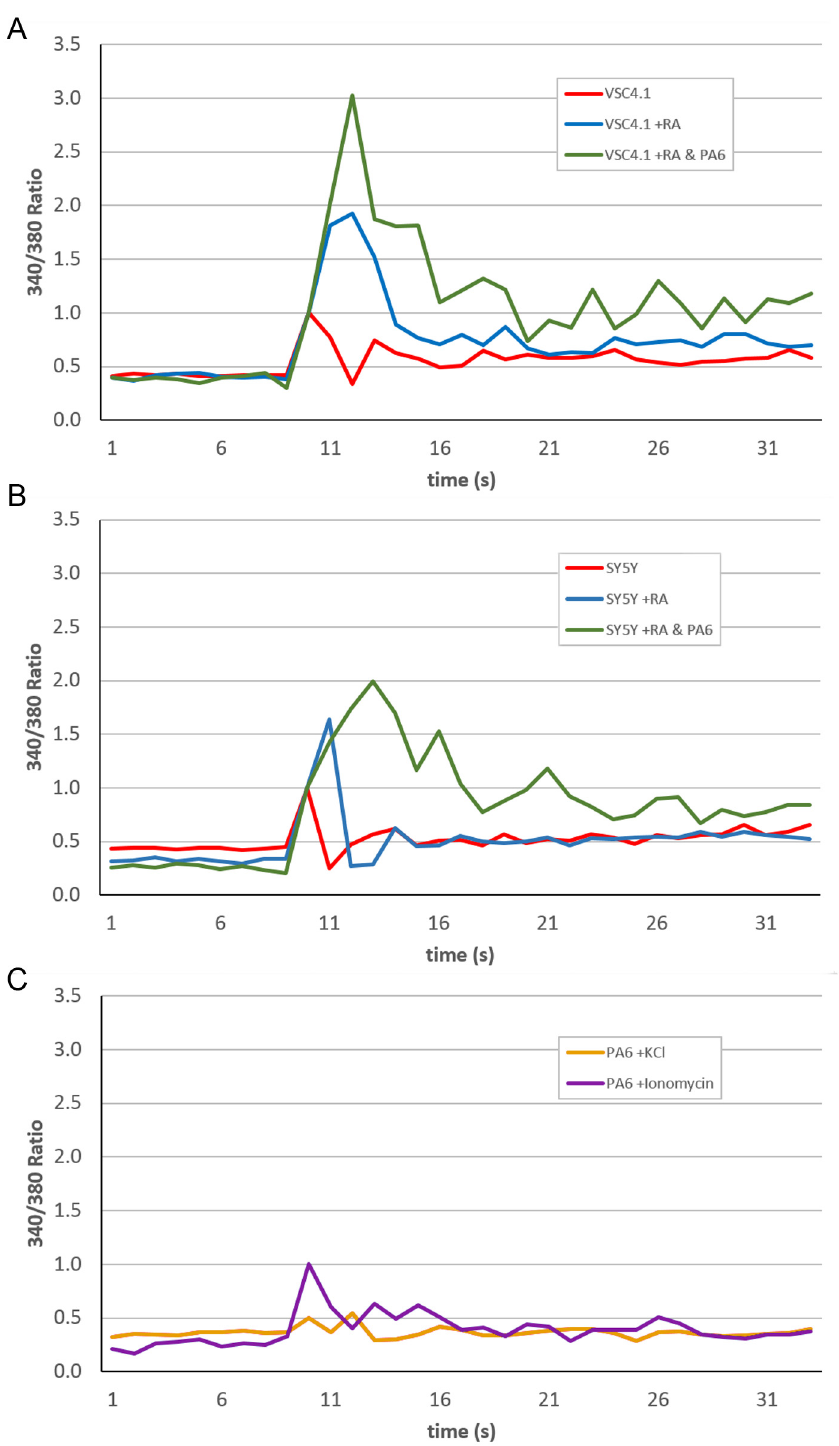
Fig 6. PA6 co-culture results in increased calcium influx in response to stimulus. Ratio of Fura-2 fluorescence emission after 340nm and 380nm excitation in (A) VSC4.1 (B) SY5Y; In both cases cell lines assayed include undifferentiated or differentiated with or without PA6, (C) PA6 alone. Wells were assayed over 40s with stimulus addition at 10s. Stimulus was 50mM KCl and 2 μ M ionomycin was used as a positive control. Ratios calculated from mean of triplicate wells, representative data from two independent